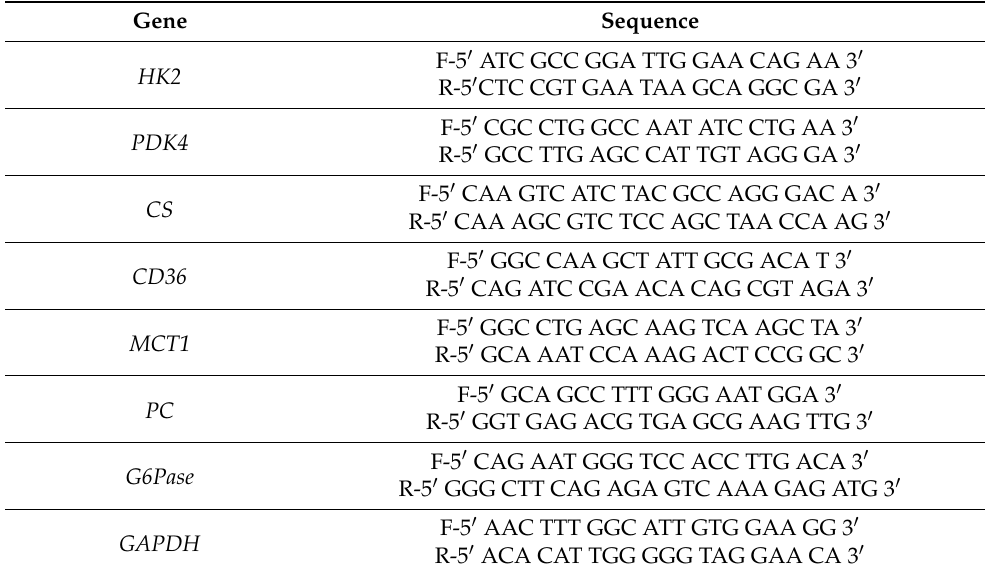
Table 3. Primer sequences for reverse transcription-polymerase chain reaction